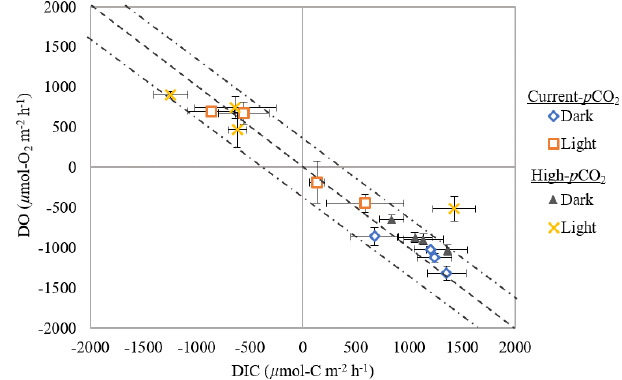
Figure 4. DIC:DO fluxes from sediment (µmolCm − 2 h − 1 or µmolO 2 m − 2 h − 1 ) for all temperatures in dark-and-light cycles subject to current and high- p CO 2 conditions (mean ± SD). Dashed line highlights the 1:1 ratio ( ± 18%; Hopkinson, 1985), with val- ues falling on this line likely a result of aerobic respiration. Arrows indicate the position values would fall in if sediments were experi- encing chemical oxidation or anaerobic respiration.